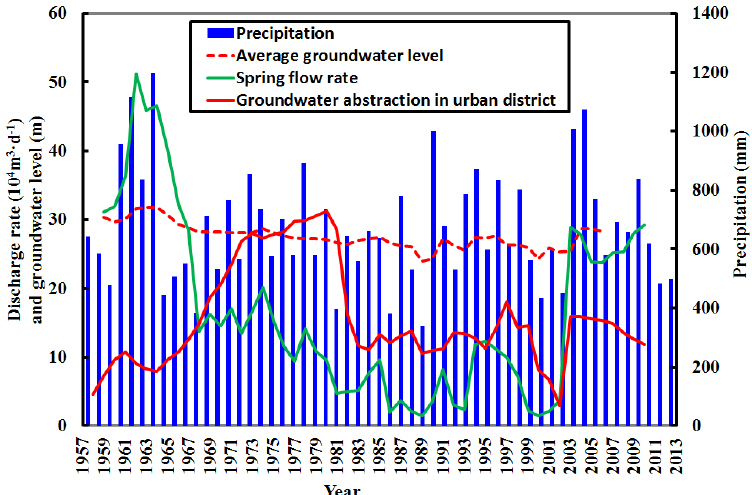
Figure 2. Changes in precipitation, the spring flow rate, groundwater abstraction and groundwater